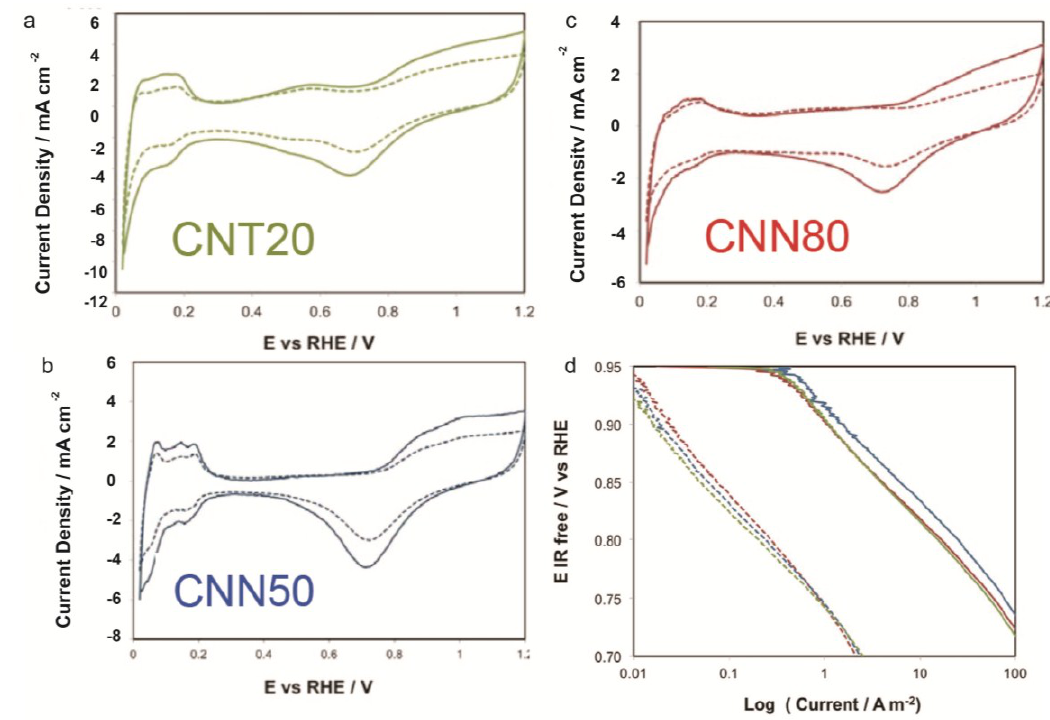
Figure 4. Cyclic Voltametry performed in 0.5 M H 2 SO 4 , N 2 saturated, scan rate 20 mV·s −1 , for ( a ) Pt-CNT20; ( b ) CNN50 and ( c ) CNN80. Before (line) and after ADT tests (dotted); ( d ) Tafel plots IR corrected. Dotted lines represent the measurements after ADT tests.